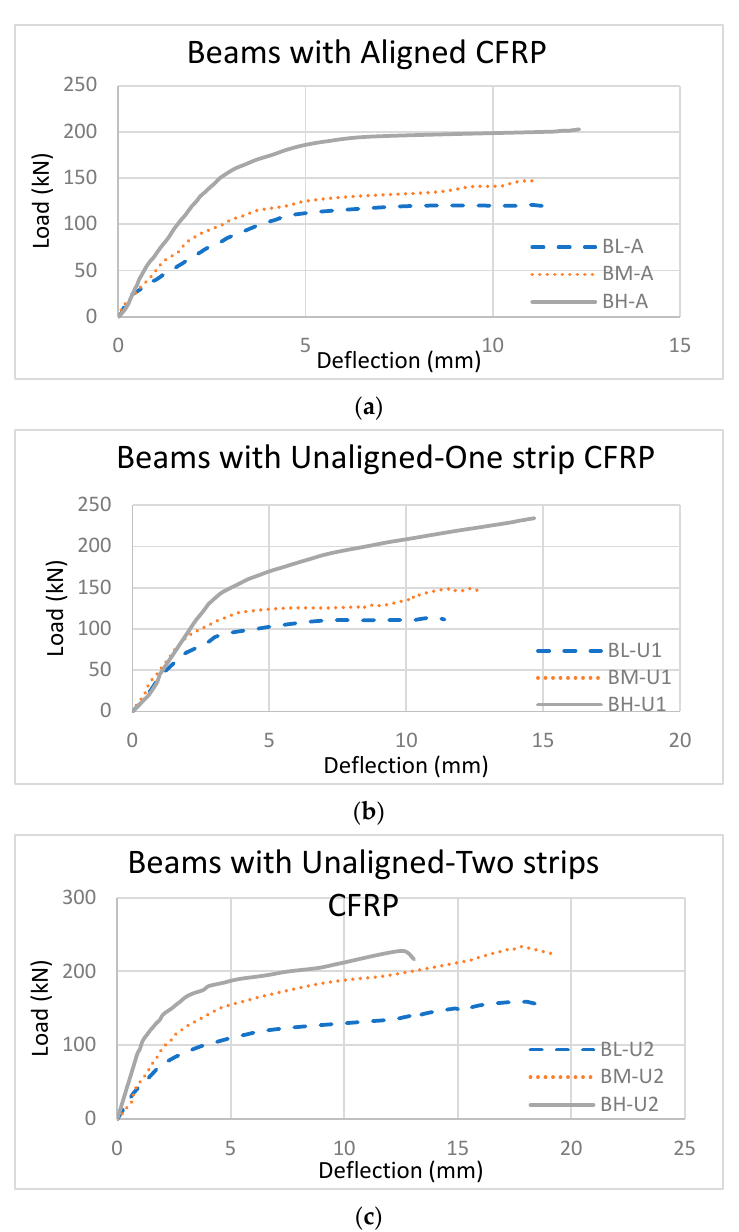
Figure 14. Comparison between beams with the same NSM ‐ CFRP configuration: ( a ) aligned, ( b ) unaligned one strip, and ( c ) unaligned two strips.